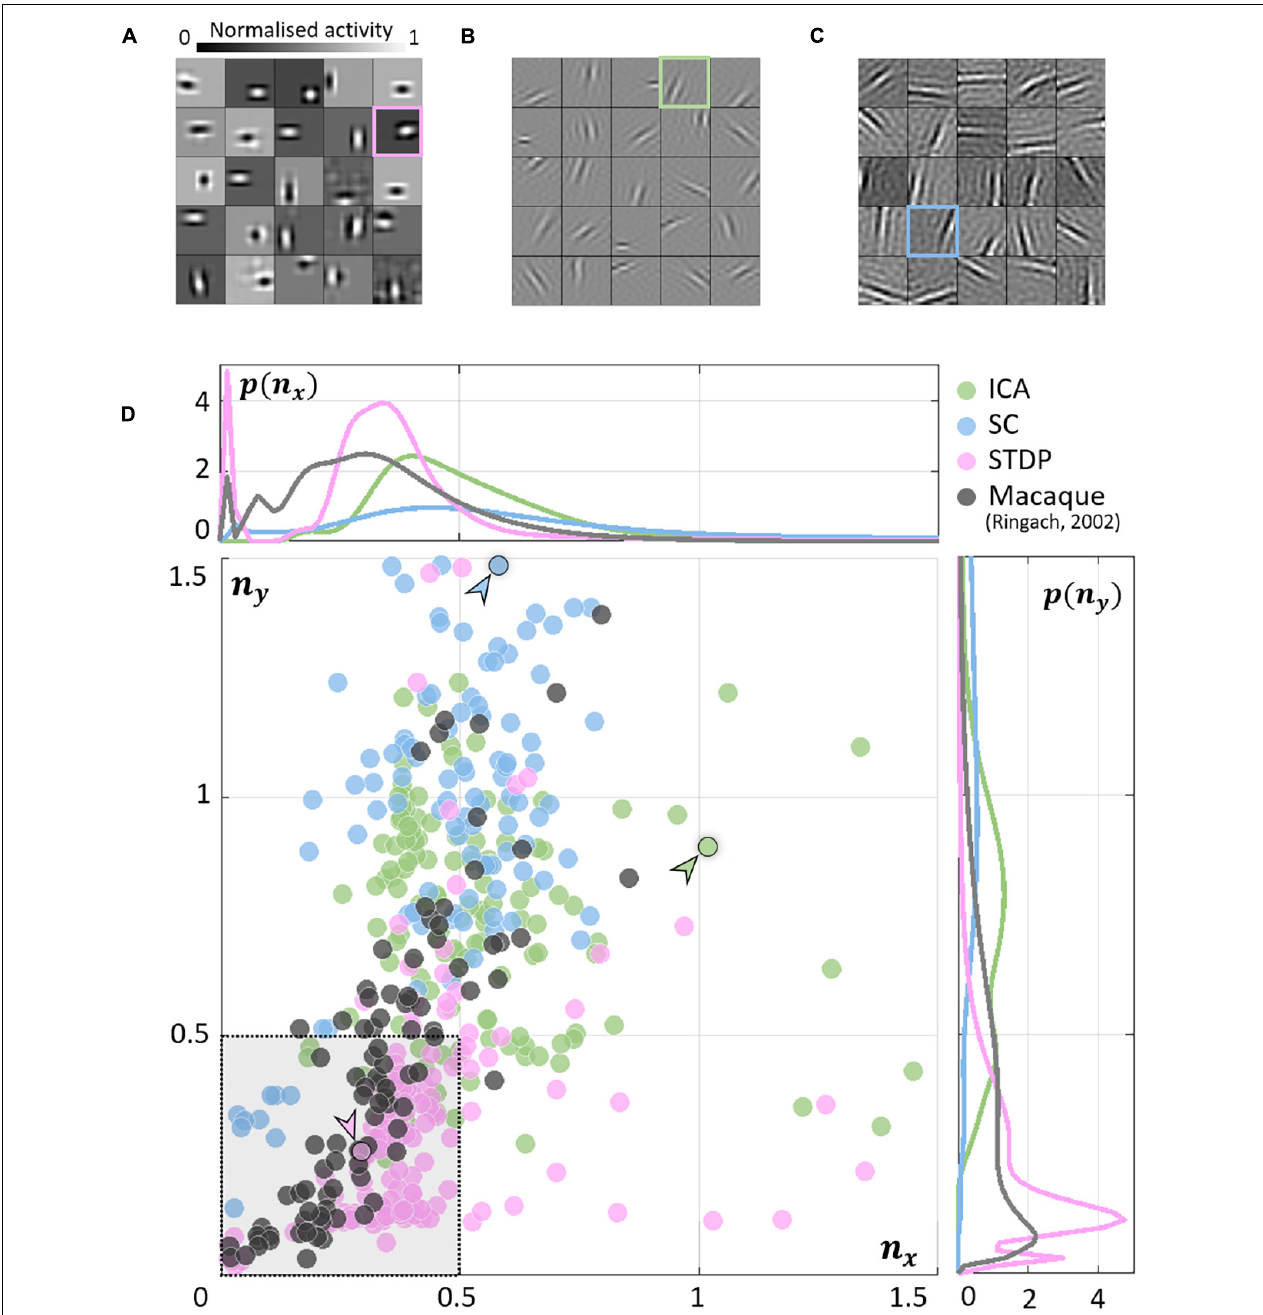
FIGURE 2 | Receptive field (RF) shape. (A–C) RFs of neurones randomly chosen from the three converged populations. The STDP population is shown in (A) , ICA in (B) , and SC in (C) . (D) Frequency-scaled spread vectors (FSVs). FSV is a compact metric for quantifying RF shape. n x is proportional to the number of lobes in the RF, n y is a measure of the elongation of the RF, and values near zero characterise symmetric, often blobby RFs. The FSVs for STDP (pink), ICA (green), and SC (blue), are shown with data from macaque V1 (black) (Ringach, 2002). Measurements in macaque simple-cells tend to fall within the square bound by 0.5 along both axes (shaded in grey, with a dotted outline). Three representative neurones are indicated by colour-coded arrows: one for each algorithm. The corresponding RFs are outlined in (A–C) using the corresponding colour. The STDP neurone has been chosen to illustrate a blobby RF, the ICA neurone shows a multi-lobed RF, and the SC neurone illustrates an elongated RF. Insets above and below the scatter plot show estimations of the probability density function for n x and n y . Both axes have been cut-off at 1.5 to facilitate comparison with biological data.